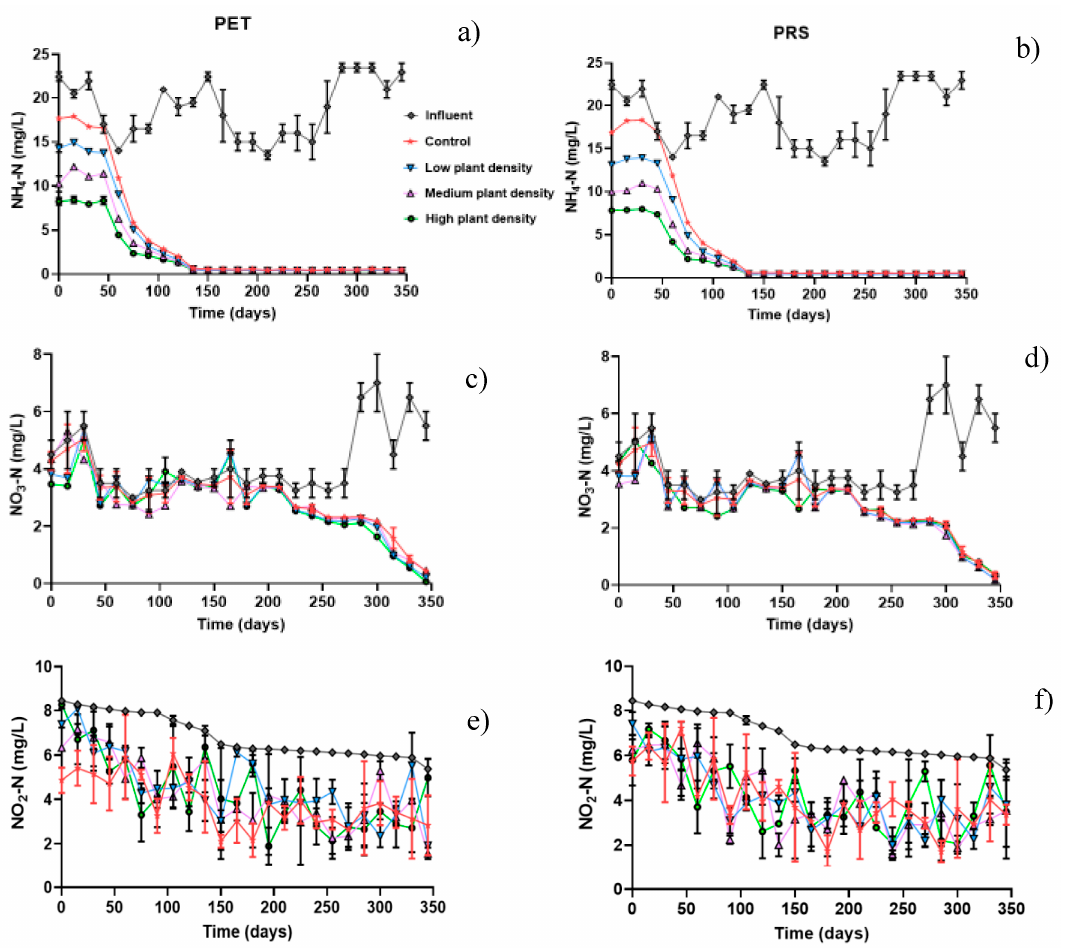
Figure 5. Concentrations of the contaminants, ( a ) NH 4 -N in PET, ( b ) NH 4 -N in PRS, ( c ) NO 3 -N in PET, ( d ) NO 3 -N in PRS, ( e ) NO 2 -N in PET, and ( f ) NO 2 -N in PRS substrates.